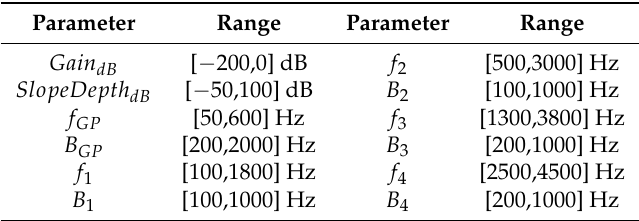
Table 1. Range of values used in the proposed